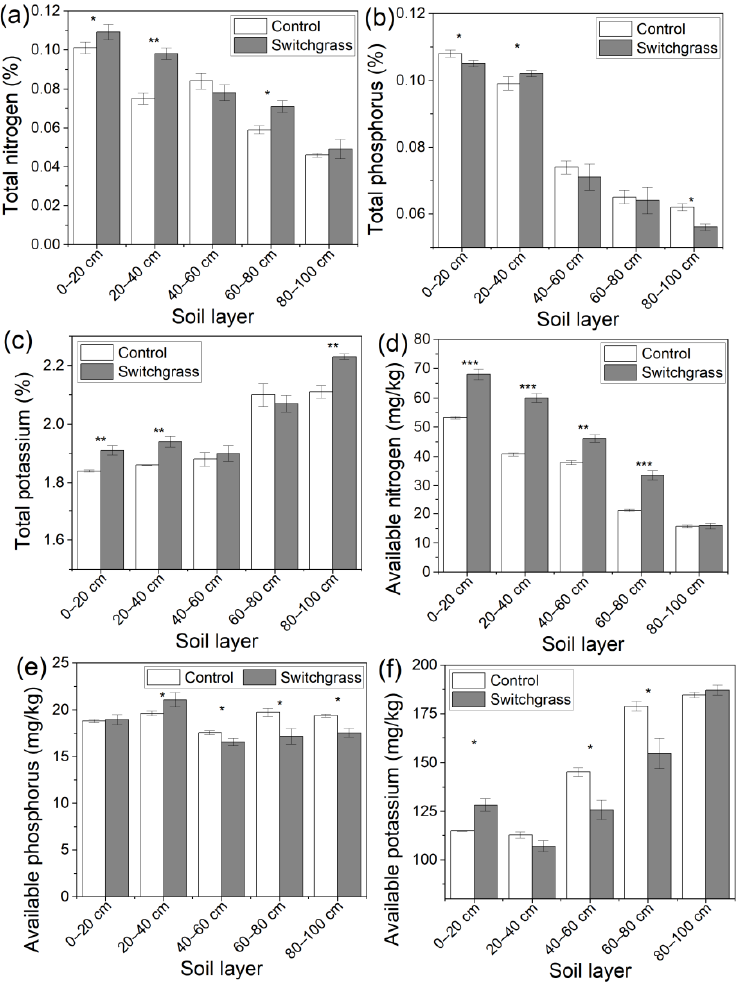
Figure 3. Soil total ( a ) nitrogen, ( b ) phosphorus, ( c ) potassium, and available ( d ) nitrogen, ( e ) phos- phorus, ( f ) potassium in the bare land and switchgrass-cultivated land. Error bars (standard deviation) were correctly added at the top of the mean columns. A Wilcoxon rank-sum test was used to analyze the significant differences between the bare land and switchgrass cultivated land at p < 0.05 (*), 0.01 (**), and 0.001 (***)